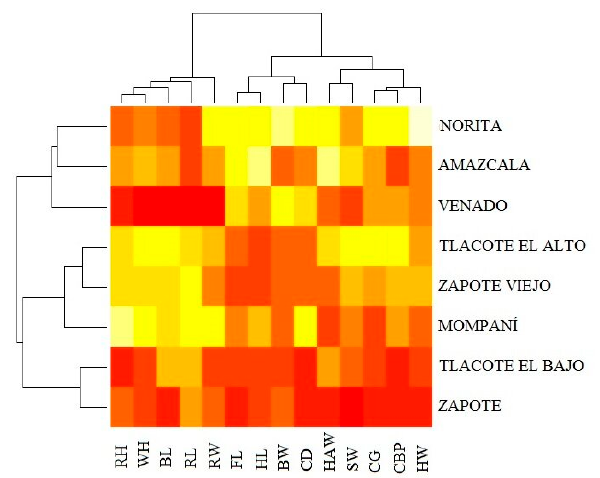
Table 5. Matrix of Euclidean distances among studied localities.